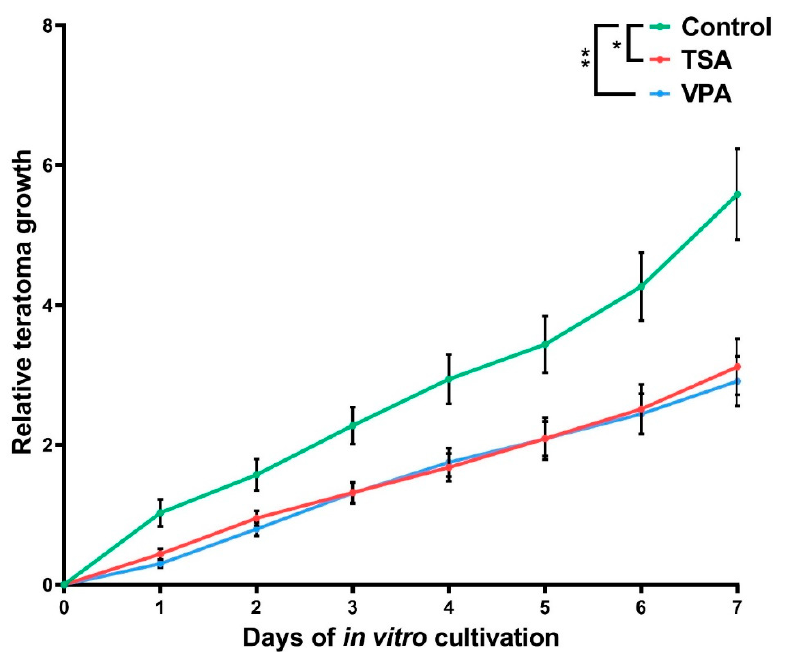
Figure 3. Teratoma growth during in vitro cultivation. The measured size of each teratoma was normalized to the measured size at day 0 of sample plating. Values represented are means with 95% CI. Asterisks were used to depict statistical significance, * p < 0.05, ** p < 0.01.